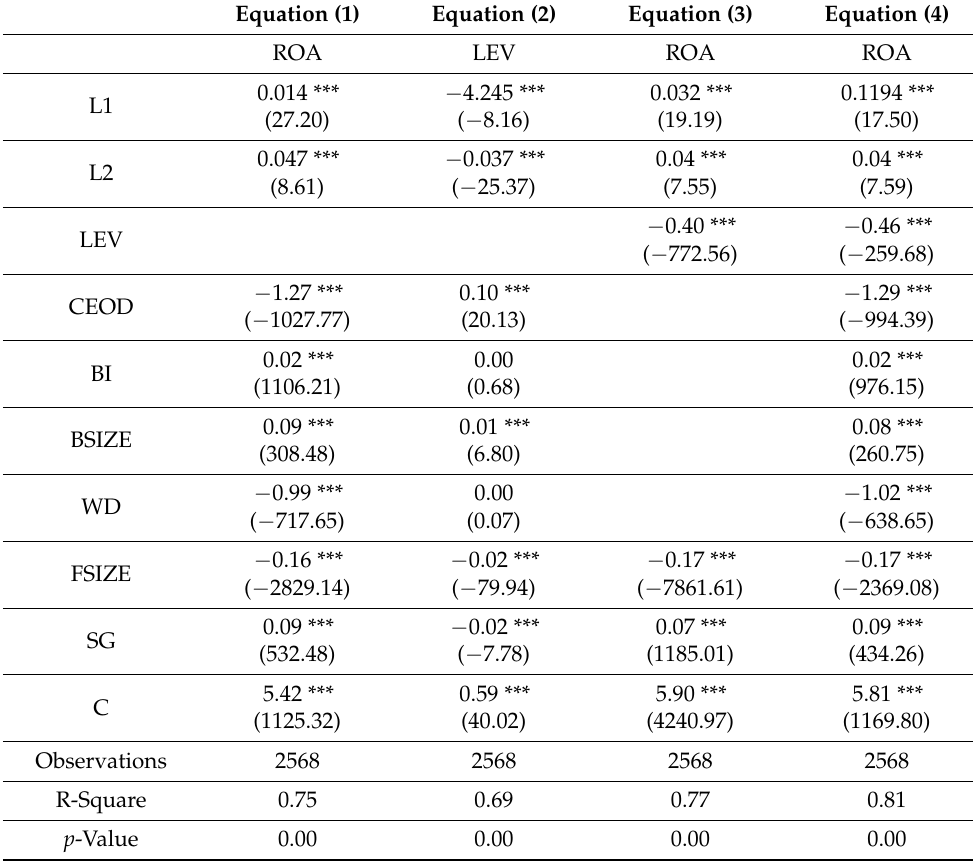
Table 5. Two-step system dynamic panel estimation across emerging